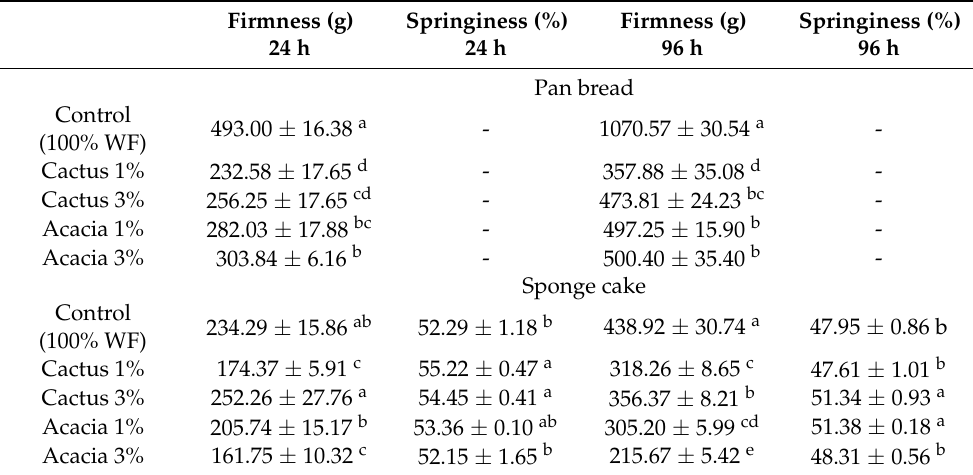
Table 6. Effect of acacia and cactus gums on the textural profile of bread and cake